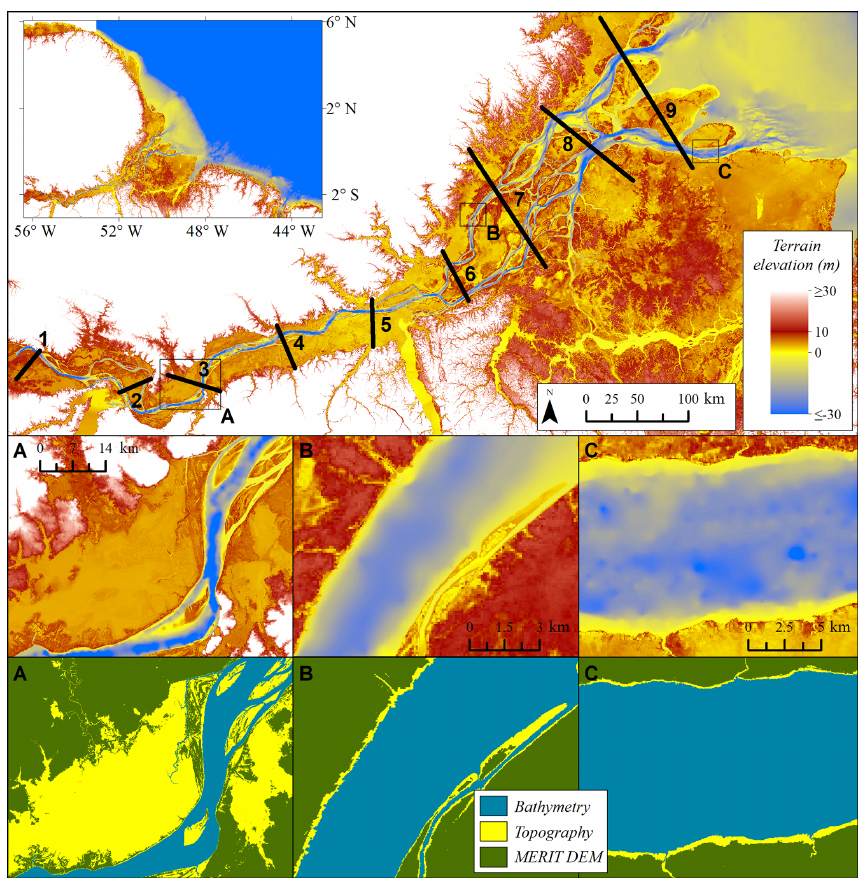
Figure 7. Unified topographic mapping of the Amazon estuary (referenced to EGM08): the bathymetry, topography, MERIT, and GEBCO products were merged. The middle row displays close-up views of selected regions. The bottom row indicates the sources of the raw data for the various